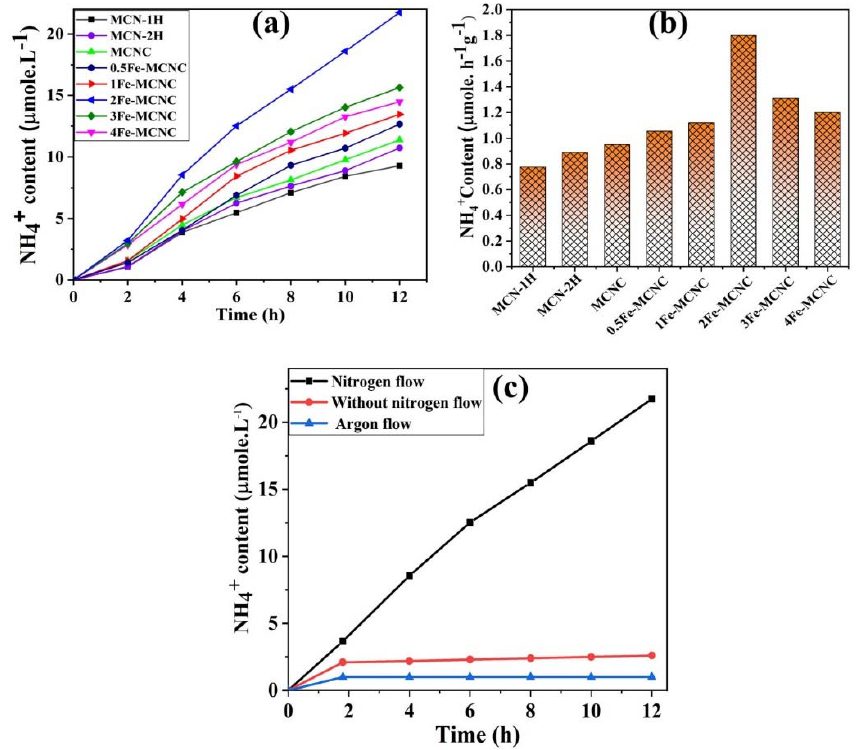
Figure 10. ( a , b ) The photocatalytic N 2 fixation performance of MCN and the Fe ‐ MCNC nanostructure. ( c ) Control experiment for photocatalytic N 2 fixation. ( c ) Control experiment for photocatalytic N 2